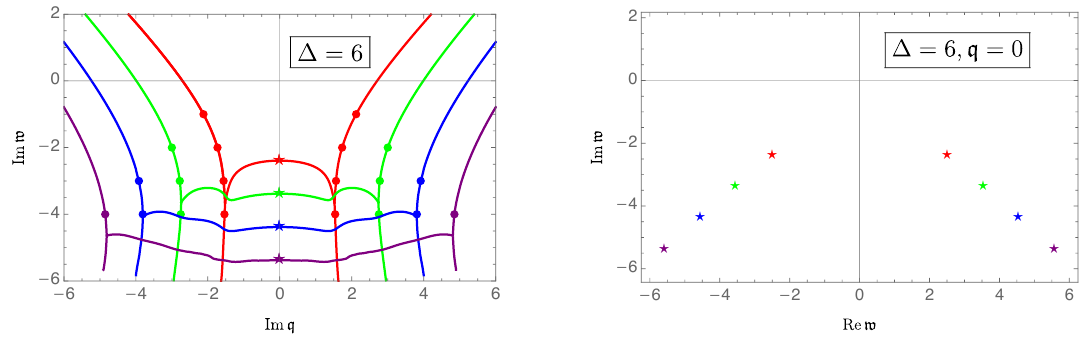
Figure 1 . Left panel: massive scalar dispersion relations for the lowest four QNMs evaluated at purely imaginary momenta, i.e. Re q = 0 . The stars lying on the vertical axis denote the imaginary part of the QNMs at q = 0 . Colorful dots show the pole-skipping points at frequencies Im w = − 1 , − 2 , − 3 , − 4 . Right panel: spectrum of the lowest four QNMs at q = 0 . These poles are exactly the poles indicated by stars in the left panel. We have checked that this same figure arises for all values of ∆ as well as for massive vector and tensor fields which will be discussed in section